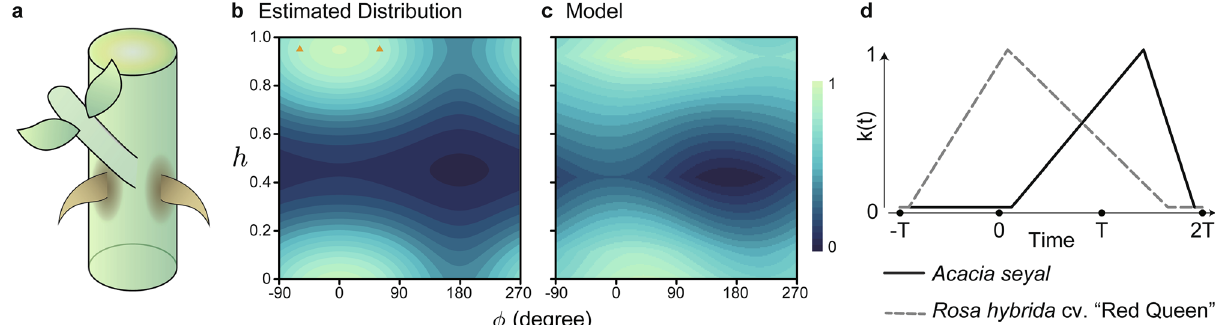
Figure 3. The prickle development model reproduced another prickle pattern on the stem of other plant species. ( a ) The pair prickles associated with leaf base of A. seyal (The graphical view is drawn with reference to the book of Adrian et al., pp. 146 and 147 11 ). ( b ) The h - φ plane representing the estimated prickle pattern of A. seyal ; a pair of prickles locates at h = 0.95 and φ = 60 ◦ , − 60 ◦ (orange triangles). ( c ) Computer simulation of prickle density using a set of optimized parameters at α = 0.044 , β = 0.102 , T a = 0.109 , T b = 1.419 and T c = 1.925 . The Pearson’s correlation to the data of ( b ) is 0.94. ( d ) Plot of the time-dependent production rate k ( t